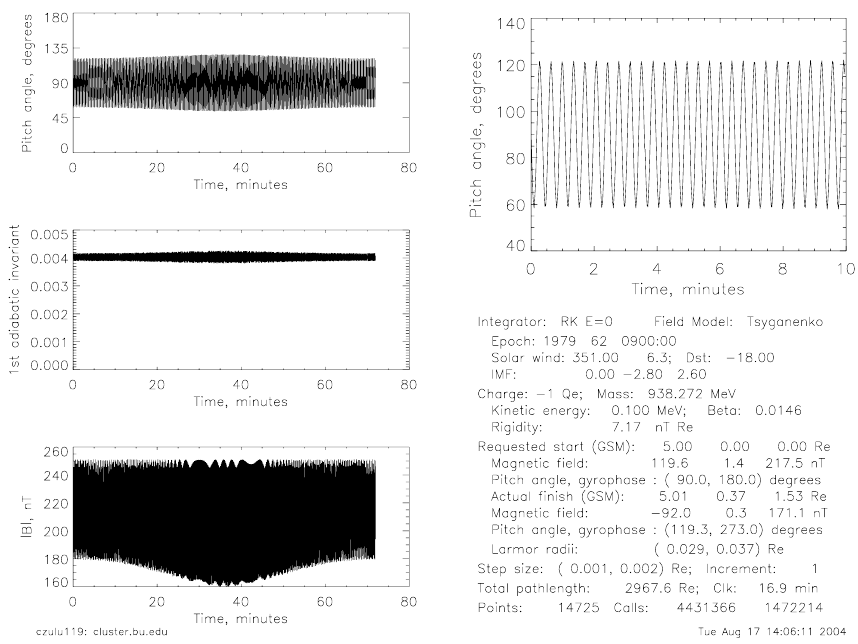
Fig. 12. Continued example of TRAJGEN run for the proton particle of Fig. 11. The pitch angle of the particle and its first adiabatic invariant are both plotted as a function of time. The magnitude of the magnetic field (as calculated using the T96 model) is also plotted versus time. A close up of the pitch angle of the particle versus time for the first 12min is also